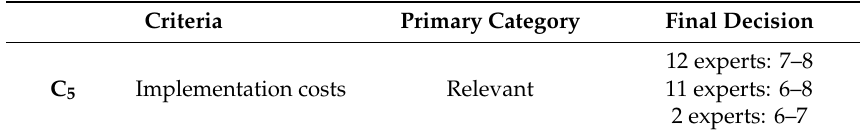
Table 3. Experts’ opinions on a selected